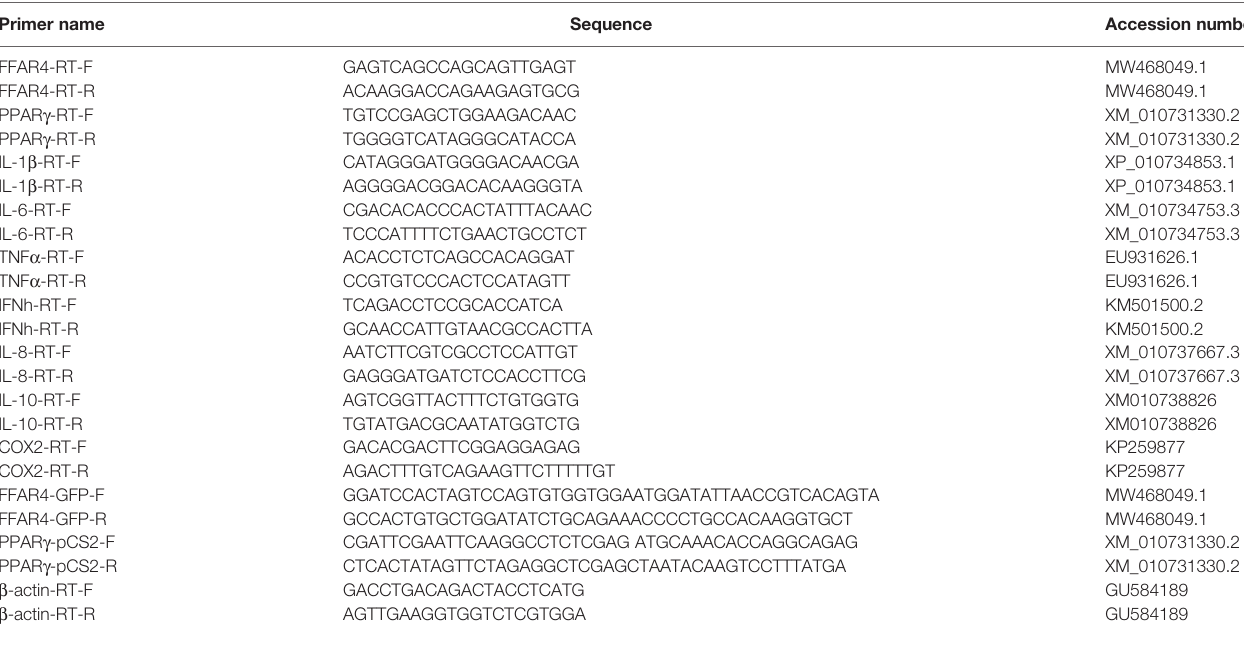
TABLE 1 | Primer sequences for cloning and